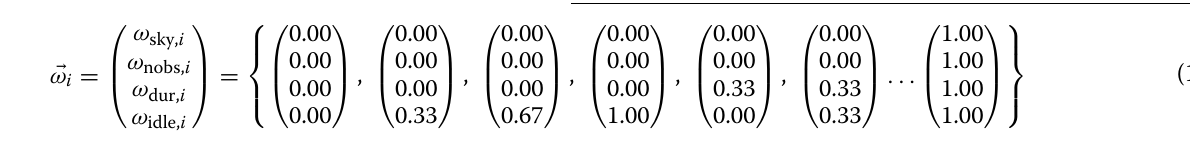
1 and 18 1 station training networks + +